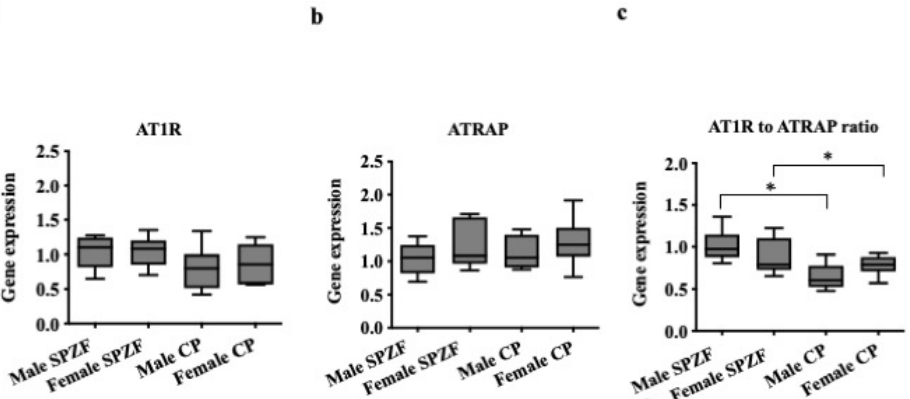
Figure 4. mRNA expression of angiotensin II type 1a receptor (AT1R, a ), AT1R-associated protein (ATRAP, b ), and AT1R to ATRAP ratio ( c ) in renal arterial perivascular adipose tissues (PVAT) of male and female SHRSP.Z- Lepr fa /IzmDmcr rats (SPZF) and SHR/NDmcr-cp rats (CP) at 23 weeks of age. * p < 0.05. Data are expressed as means ± SEM. n = 9 rats/group. * p < 0.05. Statistical comparisons of means between groups were performed using a two-way ANOVA followed by Bonferroni post hoc test.